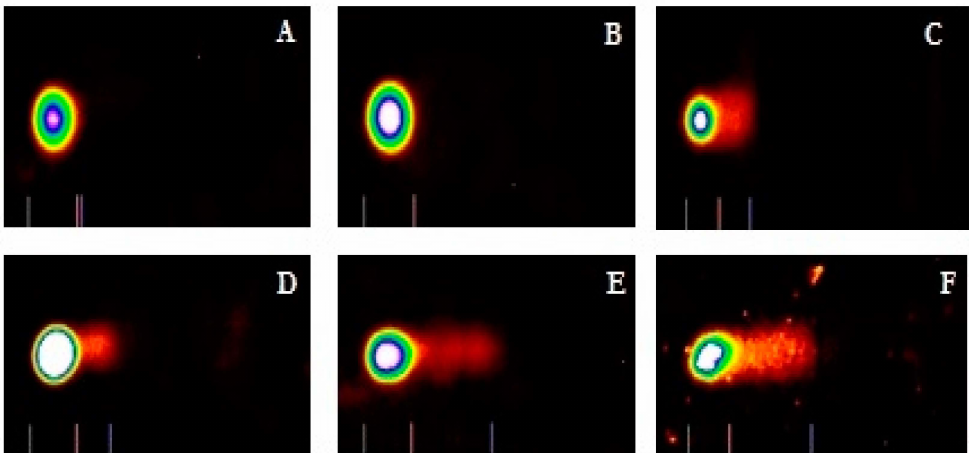
Figure 3. Cadmium chloride induced DNA damage in human liver carcinoma (HepG 2 ) cells. Cells were treated for 48 hours with medium ( A ) supplemented with solvent or 1 ( B ); 2 ( C ); 3 ( D ); 4 ( E ); and 5 ( F ) µ g/mL cadmium chloride. Representative comet images were analyzed using LAI’s Comet Assay Analysis System software (Loates Associates, Inc. Westminster, MD, USA).